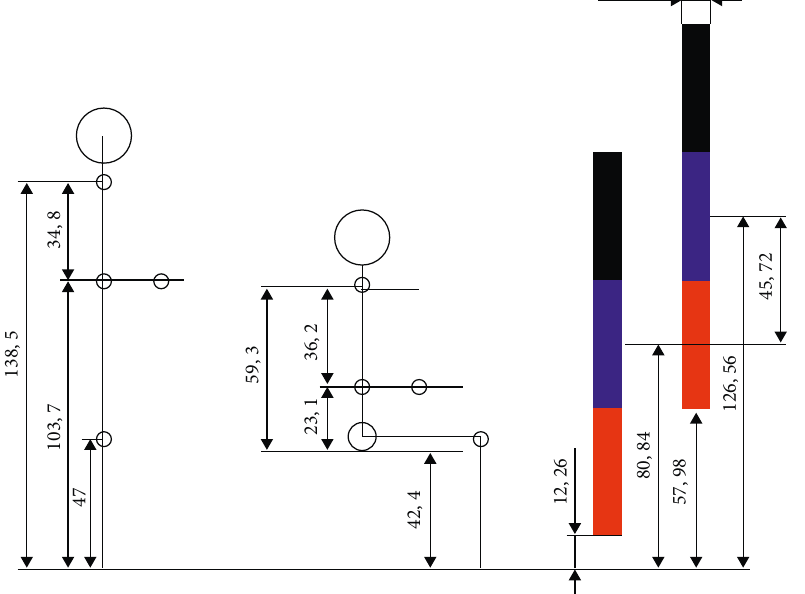
Figure 2: Standing and sitting position of operator for drilling with vertical movement of the